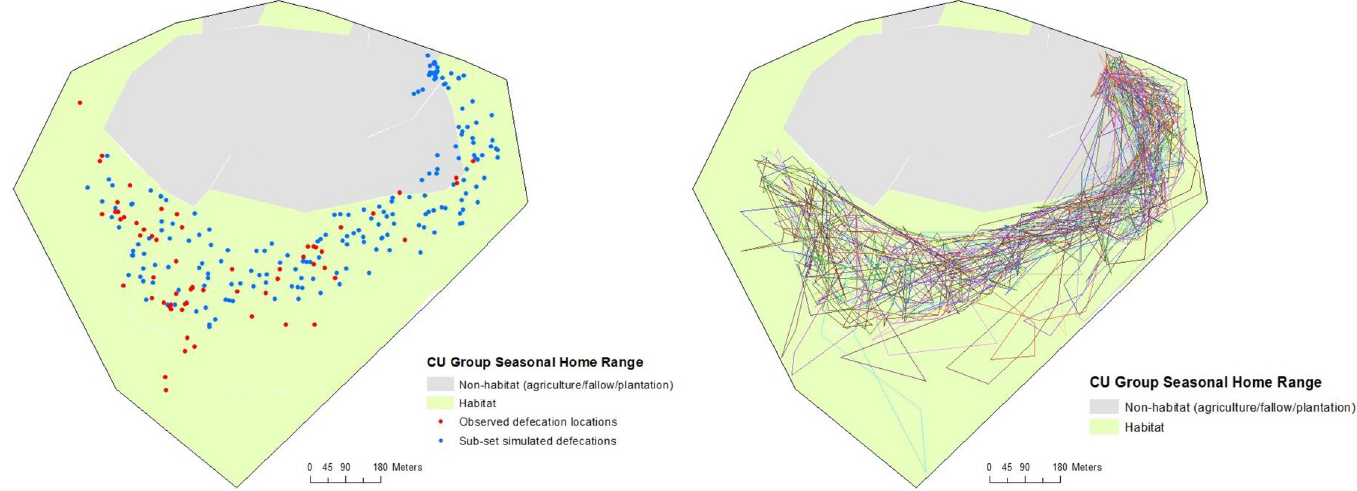
Fig 5. Map of sub-set of simulated defecation events, with distance to Pourouma genus tree of 10 m and mature fruit threshold of 0.3, from MOST and observed defecation events within the seasonal home range of tamarins (left) and sub-set of simulated trajectories (right), in Coloˆnia de Una, Brazil.